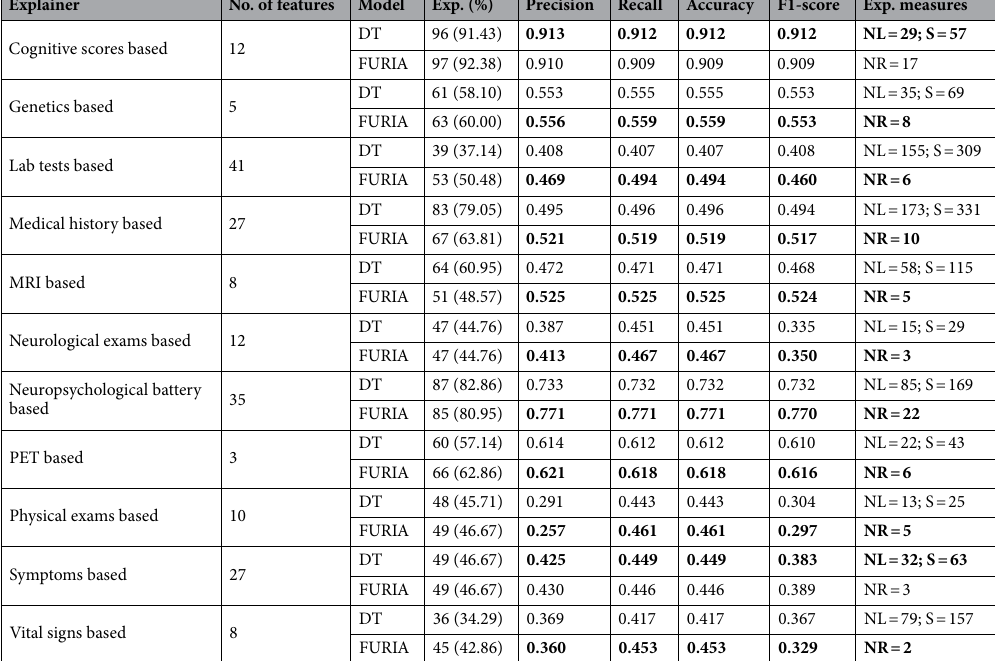
Table 9. The performance of the explainers on different modalities (First Layer). Exp. measures, explainability measure; NL, number of leaves; S, size of the tree; NR, number of rules; Exp. (%), the number of explained cases (percentage of coverage); values in bold indicate the best performance.